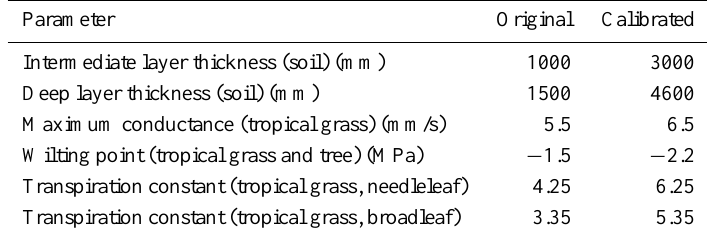
Table 2. Modified parameter values from the original MAPSS configuration for